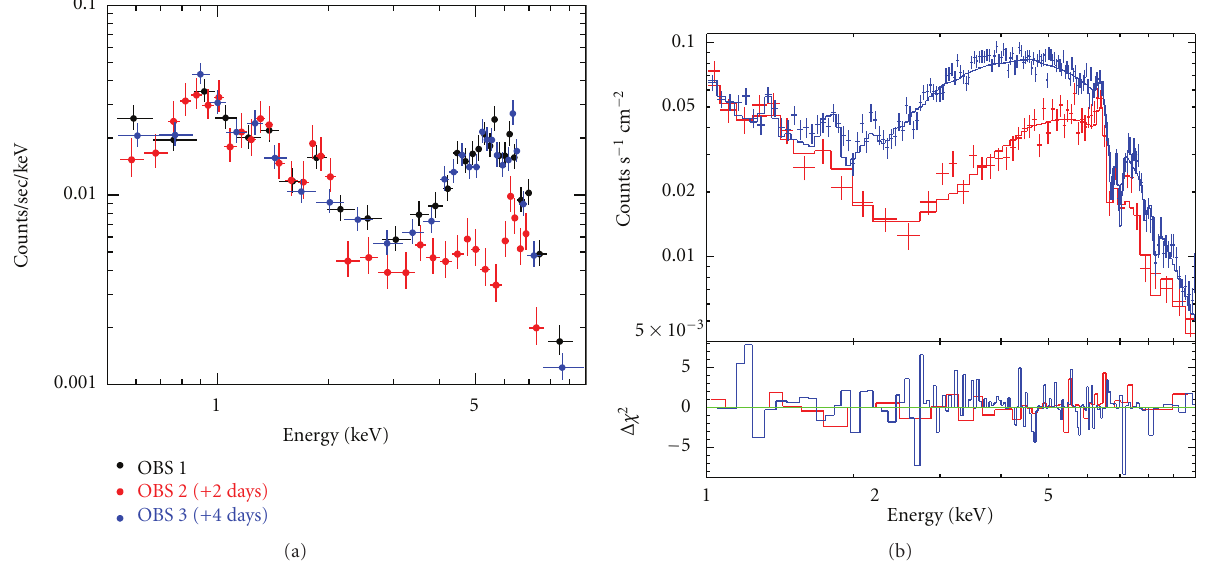
Figure 1: Spectra of NGC 1365, showing X-ray occultations due to BLR clouds: (a) spectra obtained from three Chandra snapshot observations performed every two days [43]. The reflection-dominated spectrum in the second observation is due to an occultation by a Compton-thick cloud (the only one ever detected in short time scales). (b) Spectra obtained from di ff erent intervals (length of about 10ks) of a single Suzaku observation, revealing absorption changes due to a cloud with a column density of the order of 10 23 cm − 2 .